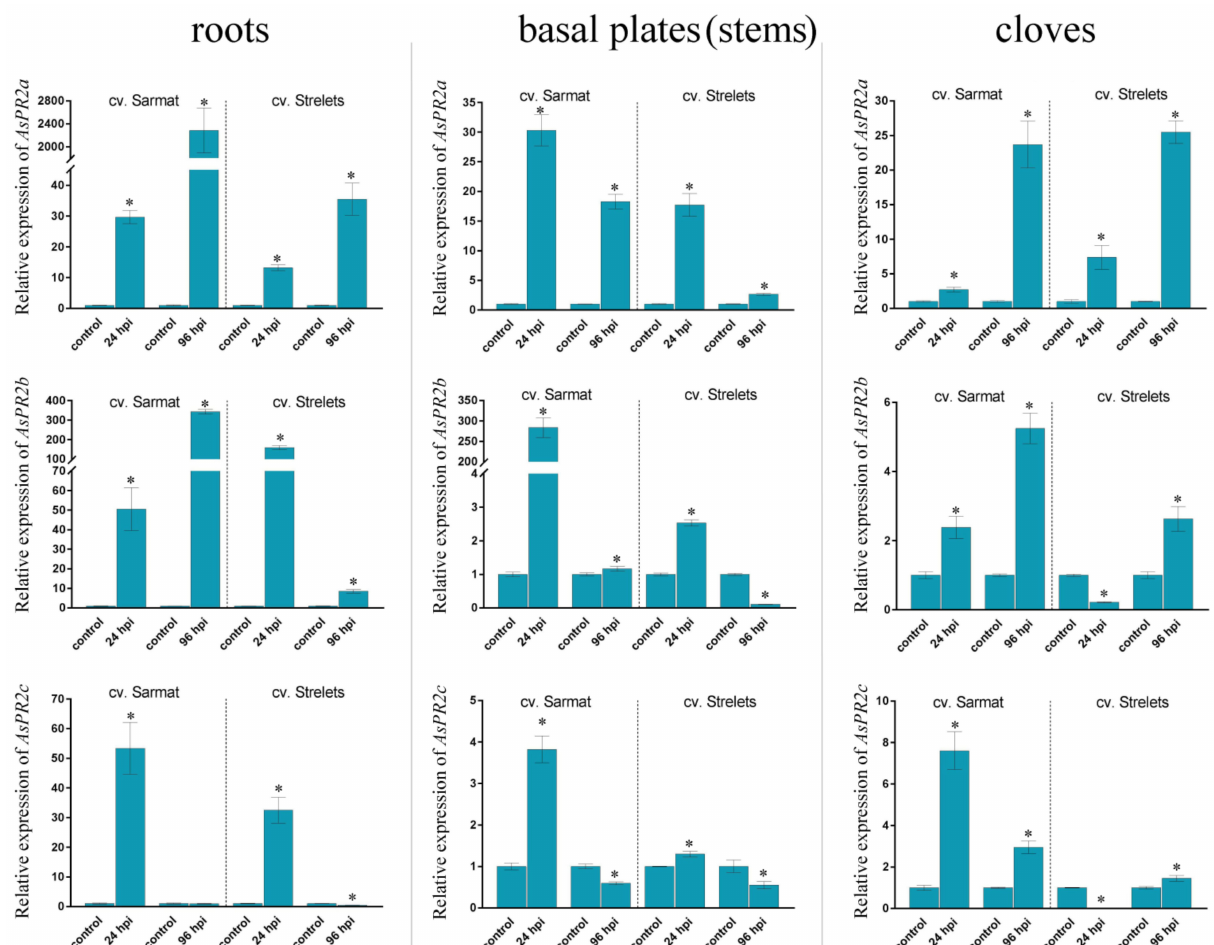
Figure 4. Expression of the AsPR2a , b , c genes in Allium sativum cv. Sarmat (FBR-resistant) and Strelets (FBR-susceptible) after Fusarium proliferatum infection. The plants were incubated with F. proliferatum conidia and analyzed for mRNA levels in the roots, stems, and cloves at 24 and 96 hpi by qRT-PCR. The data were normalized to GAPDH and UBQ mRNA levels and presented as fold change (mean ± SE) of the control taken as 1; * p < 0.01, compared to the uninfected